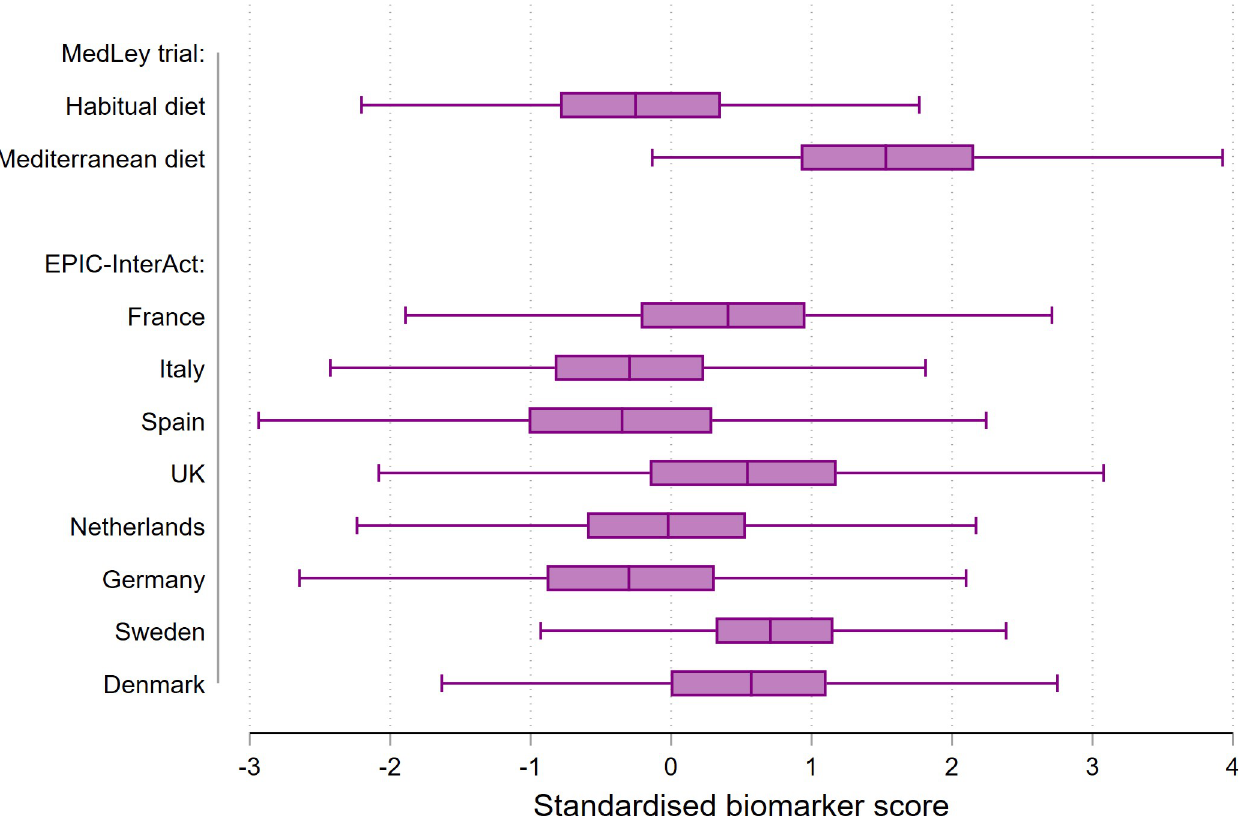
Fig 1. Nutritional biomarker score of the Mediterranean diet: study-specific distribution by the MedLey trial arms post-intervention and the EPIC-InterAct subcohort by country at baseline. AU : AbbreviationlistshavebeenupdatedforthoseusedinFigs 1 and 2 andTable 2 : Pleaseverifythatallentriesarecorrect : The biomarker score was derived as a discriminatory model between the Mediterranean and habitual diet in the MedLey randomised partial-feeding controlled trial. Circulating carotenoids and fatty acids were used to calculate the score as linear predictions from the discriminatory model. The score was standardised separately within the MedLey trial and the EPIC-InterAct subcohort. Boxes denote the IQR and medians inside; and whiskers, values up to 1.5 IQR outside of these percentiles. EPIC, European Prospective Investigation into Cancer and Nutrition; IQR, interquartile range; UK, United Kingdom.